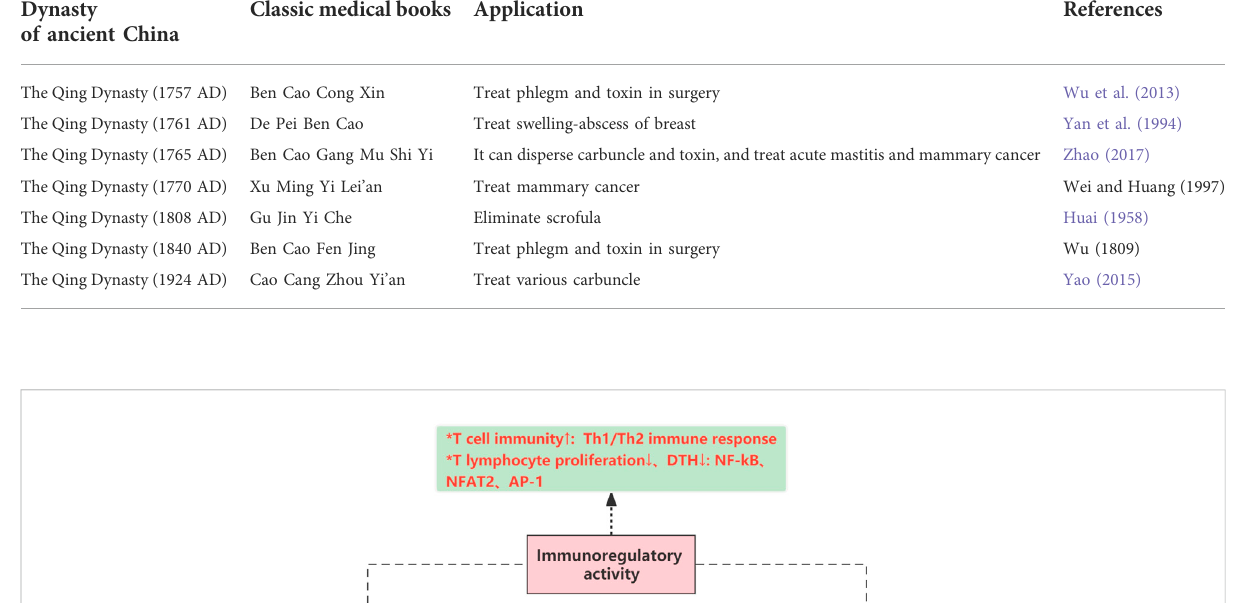
TABLE 1 Traditional application of Bolbostemma paniculatum (Maxim.) Franquet.